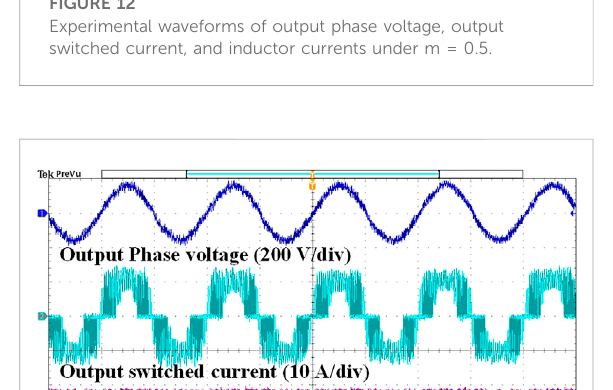
FIGURE 11 Driving pulses of switches (S 2 , S 6 , S 7-1 , S 7-2 ).